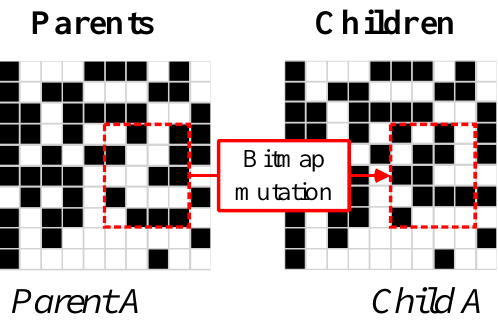
Figure 4. Illustration of 2D binary mutation.